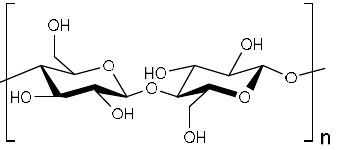
Figure 4. General chemical structure of cellulose.